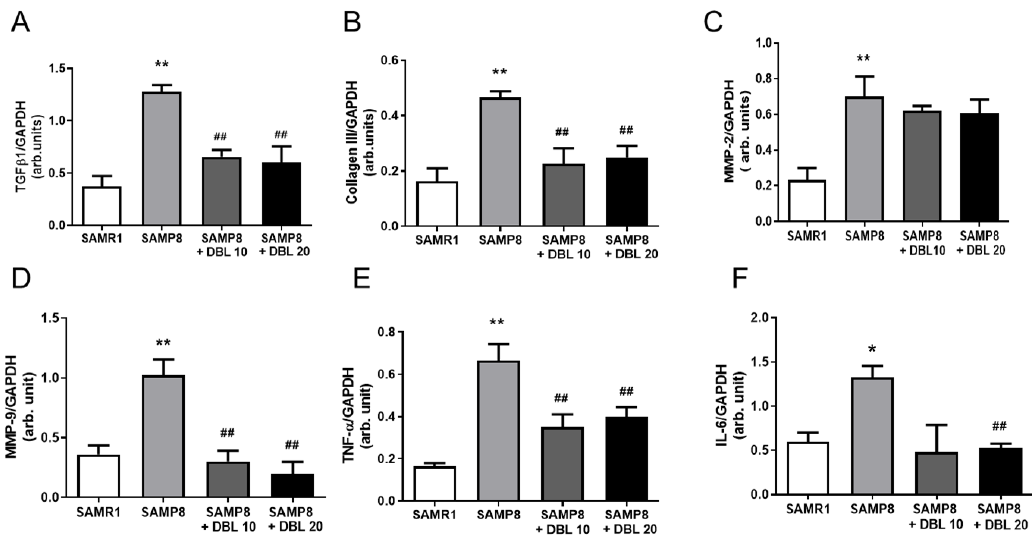
Figure 4. DBL modulates the aging-induced messenger RNA expression of inflammatory and cardiac remodeling marker genes in the heart tissue. ( A – F ). The graphs show the messenger RNA (mRNA) expression levels of A . Transforming growth factor (TGF)- β 1, B . Tumor necrosis factor (TNF)- α , C . Interleukin (IL)-6, D . Matrix metallopeptidase (MMP)-2, E . MMP-9, and F . Collagen 1. The data represent the mean ± SEM. ** p < 0.01 vs. SAMR1, ## p < 0.01 vs. SAMP8, using a one-way ANOVA followed by Tukey’s post hoc test.